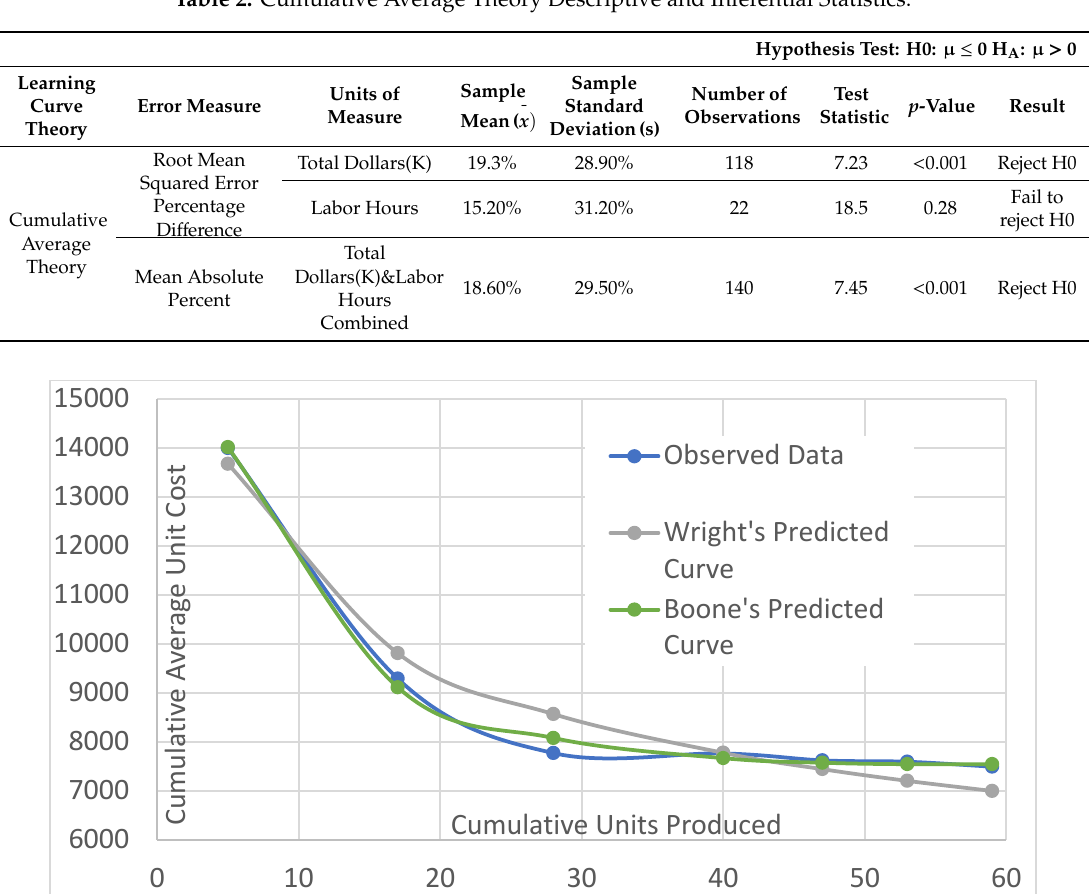
Figure 4. Comparison of Program 20 PME Air